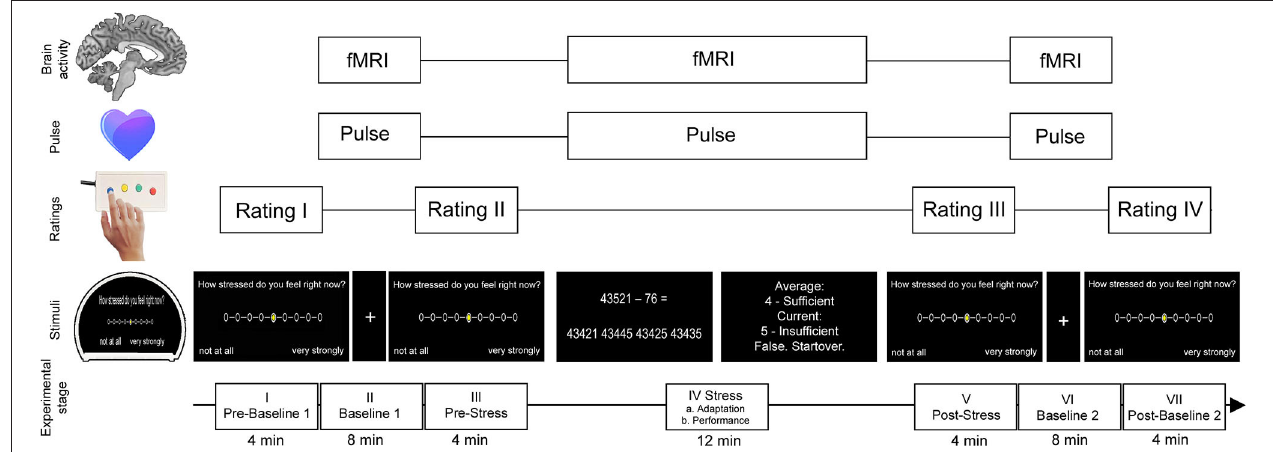
FIGURE 1 | Stress task (for details see “Methods and Materials”). The task consisted of seven stages (I–VII). Neural activity and pulse signals were measured during the first baseline stage (II), the stress stage (IV), and the second baseline stage (VI). The stress stage comprised multiple-choice arithmetic subtraction tasks each followed by feedback depending on individual performance of the participant. During the first part of this stage, the performance level of the participant was assessed (adaption stage) which served as the foundation for the participant’s individual level of difficulty for the subsequent performance part of the stress stage. During baseline stages, participants were asked to focus on a fixation cross on the MRI screen. During the prebaseline stage (I), prestress stage (III), poststress stage (V), and postbaseline stage (VII), participants were asked to rate the degree of perceived psychological stress. The figure was adapted from Meyer-Arndt et al. (